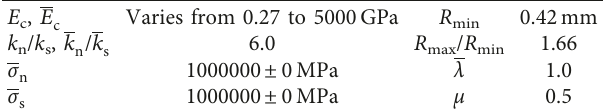
Table 4: Parameters in the PFC model for the roof and floor in the strain